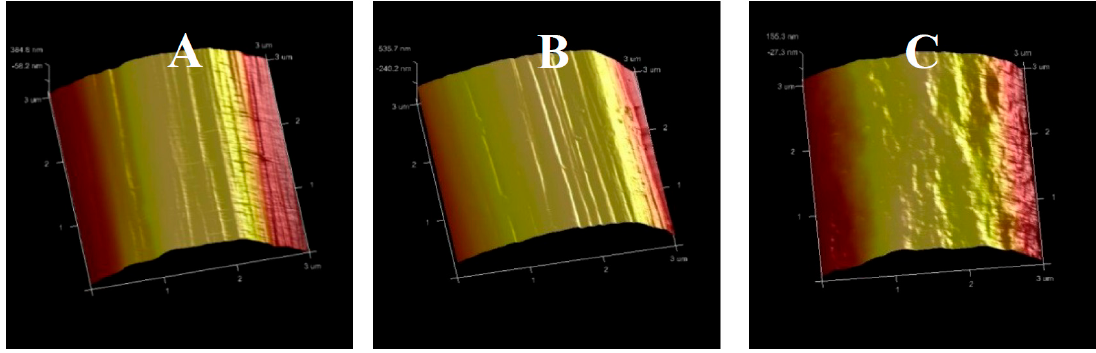
Figure 8. AFM pictures of carbon fibers: ( A ) original; ( B ) 500 °C for 30 min, and ( C ) 550 °C for 30 min.